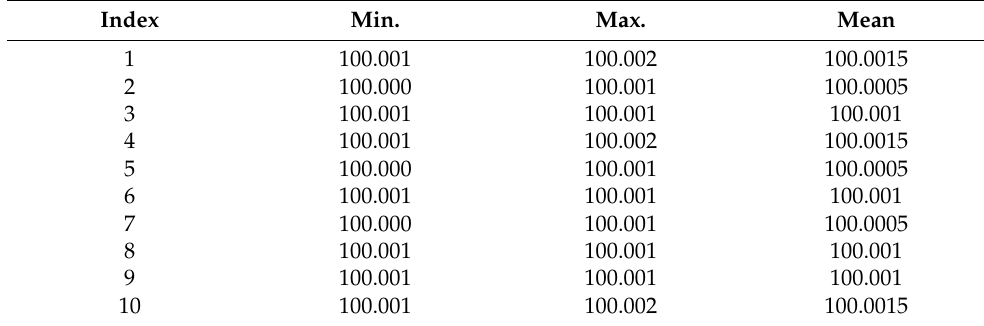
Table 4. The results of length measurements of 10 images.